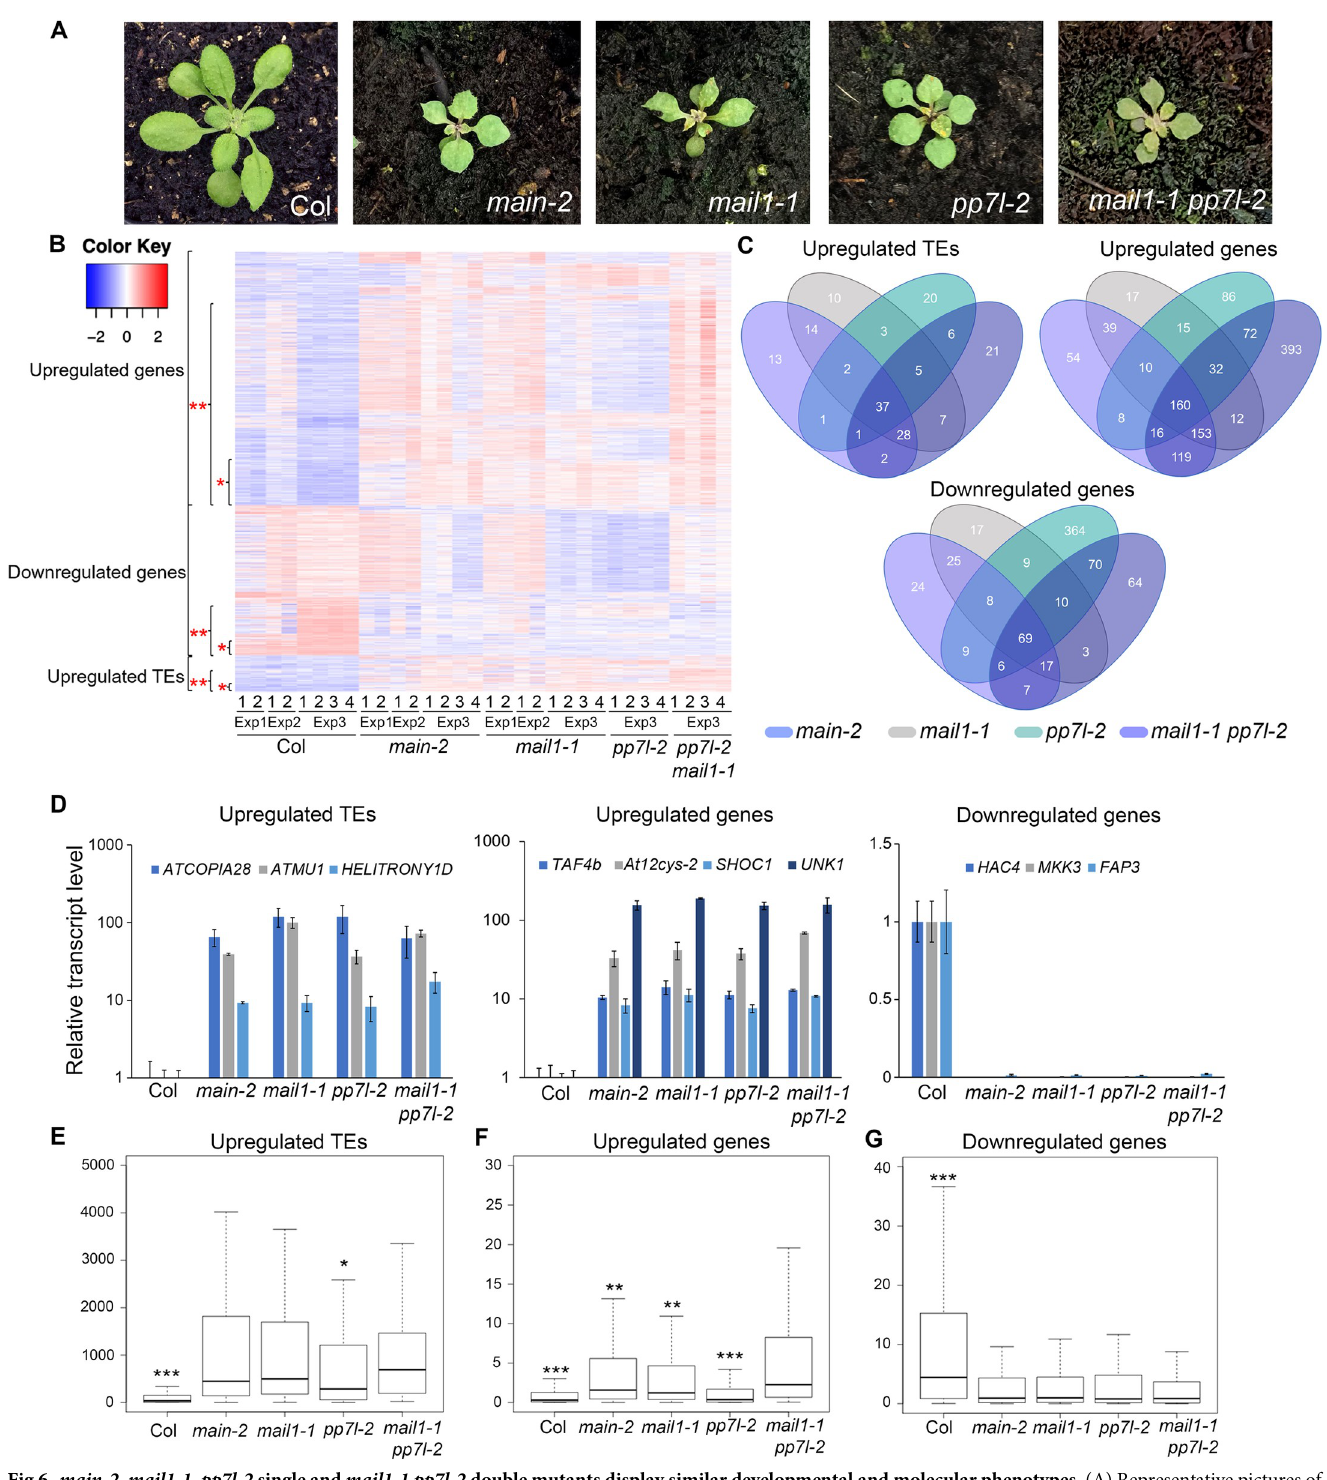
Fig 6. main-2 , mail1-1 , pp7l-2 single and mail1-1 pp7l-2 double mutants display similar developmental and molecular phenotypes. (A) Representative pictures of 3-week-old main-2 , mail1-1 , pp7l-2 single and mail1-1 pp7l-2 double mutants in comparison to WT Col plant. (B) Heatmap showing misregulated loci in main-2 , mail1-1 , pp7l-2 and mail1-1 pp7l-2 mutants in comparison to WT Col plants using the datasets of RNA-seq Exp1, Exp2 and Exp3 (S2 and S4 Tables). One asterisk defines the loci that are commonly misregulated in all mutant backgrounds. Two asterisks define the loci that are misregulated in the mail1-1 pp7l-2 double mutant. (C) Venn diagrams analyses representing the overlaps between misregulated loci in main-2 , mail1-1 , pp7l-2 and mail1-1 pp7l-2 . Fisher’s exact test